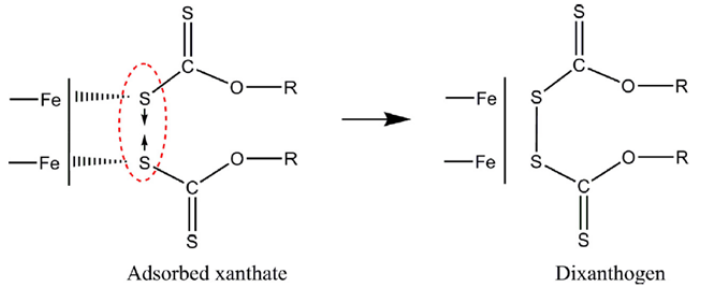
Figure 26. Dixanthogen formation on the surface of pyrite (adapted from Wills et al. [116]).